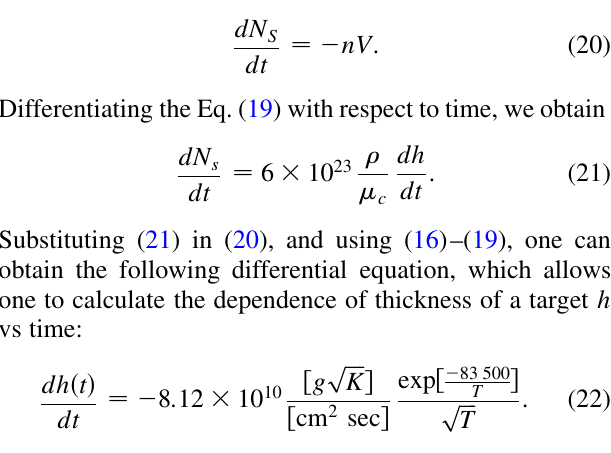
TABLE I. The parameters of H (cid:2) beams at SNS and BNL linac according to Ref. [25]. Energy Duration of an impulse Frequency The maximal current